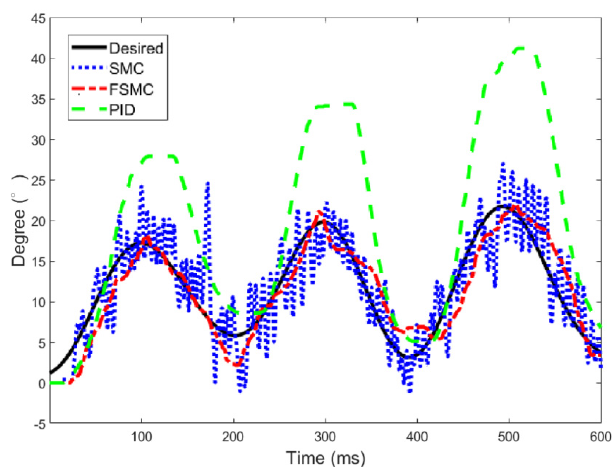
Figure 12. Trajectories of shoulder joint J 2.